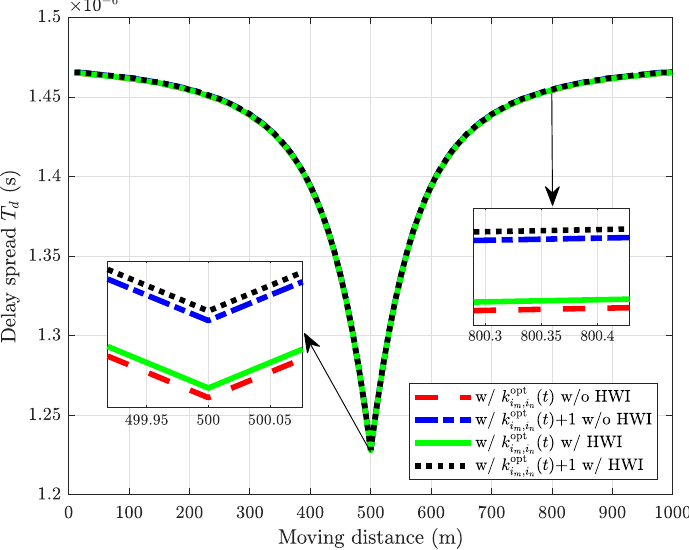
Figure 4. Delay spread for the system using different phase shift sets. K =